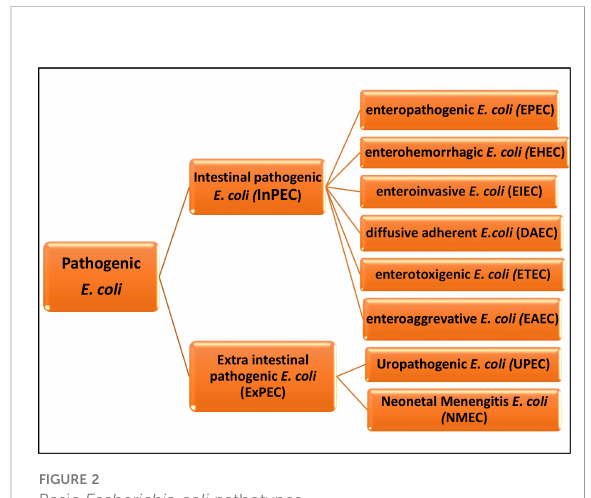
FIGURE 2 Basic Escherichia coli